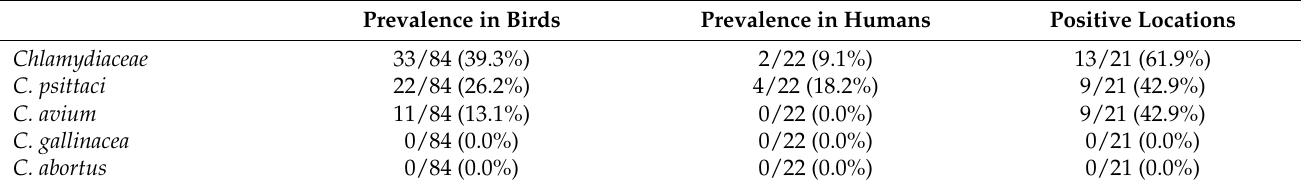
Table 2. Chlamydia infections in psittacine birds and their owners as diagnosed by PCR, Belgium, 2020–2021. Prevalence in Birds Prevalence in